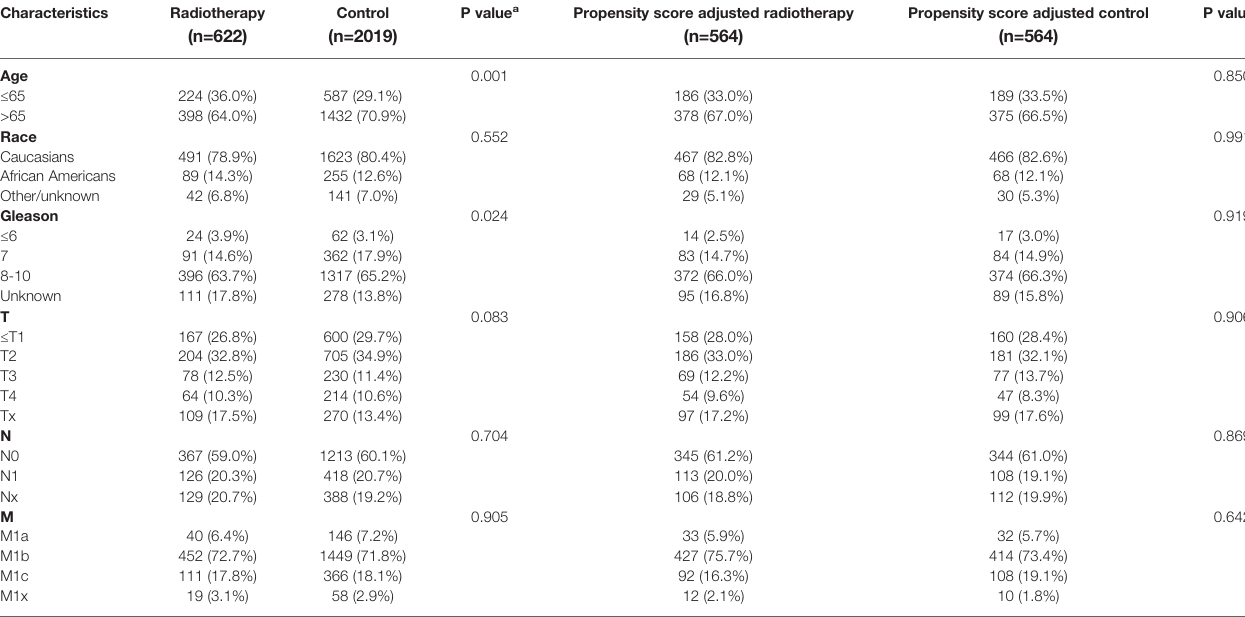
TABLE 6 | Clinicopathological characteristics of the PSA 20.1-40 ng/ml subgroup strati fi ed according to treatment modality with and without propensity score matching. Characteristics Radiotherapy P value a Propensity score adjusted radiotherapy Propensity score adjusted